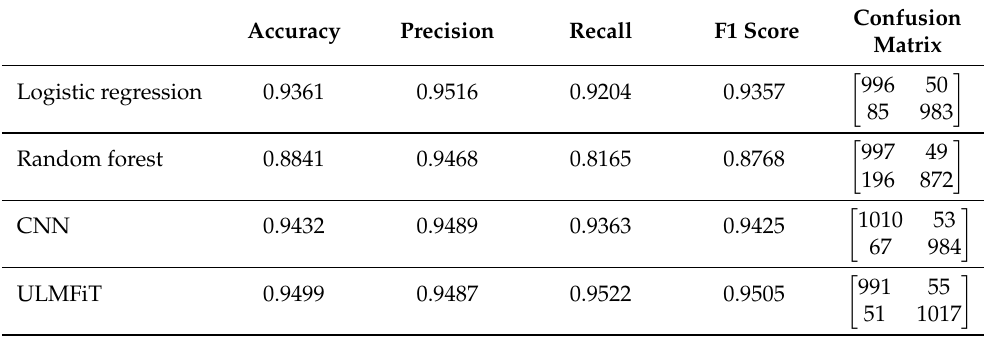
Table 1. Performance measures for the different classifiers with the model variant original tweets .